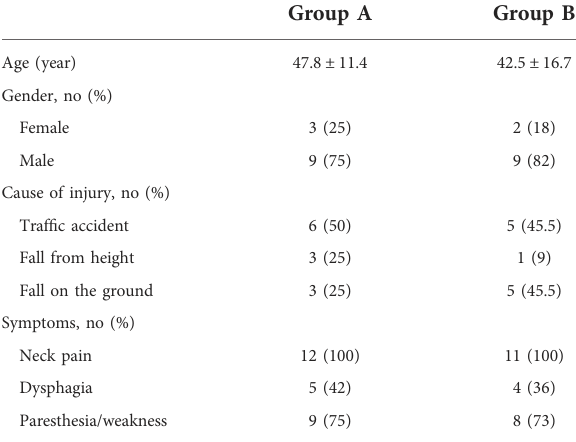
TABLE 1 Baseline characteristics of